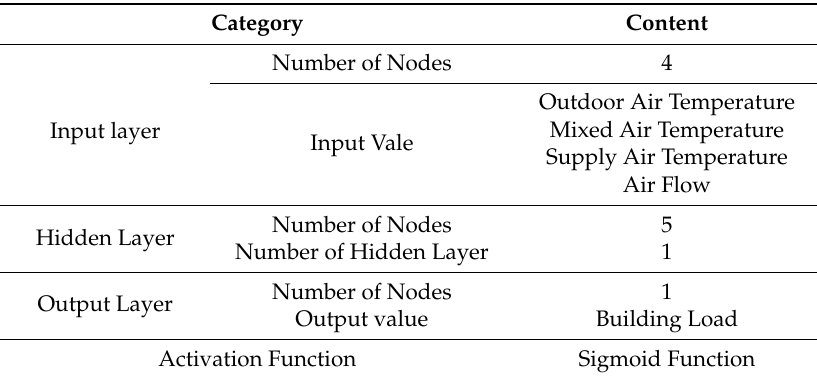
Table 5. Overview of prediction model